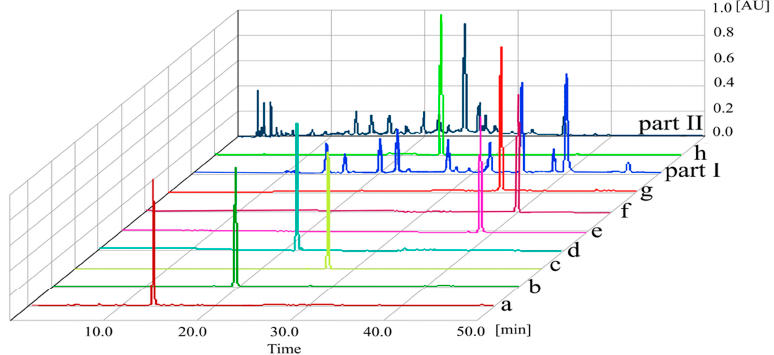
Figure 4. HPLC chromatograms of HSCCC peak fractions (a–h), part I and part II. Conditions: column, Waters Symmetry Shield™ RP18 column (250 mm × 4.6 mm i.d., 5 μ m); mobile phase, acetonitrile ( A ) 0.2% formic acid aqueous solution ( B ) (0–50 min, 5%–60% A ); Column temperature, 25 °C; Detection wavelength, 280 nm; Injection volume, 20 μ L; Flow rate, 1 mL/min. a . 3,4-dihydroxy benzoic acid, b